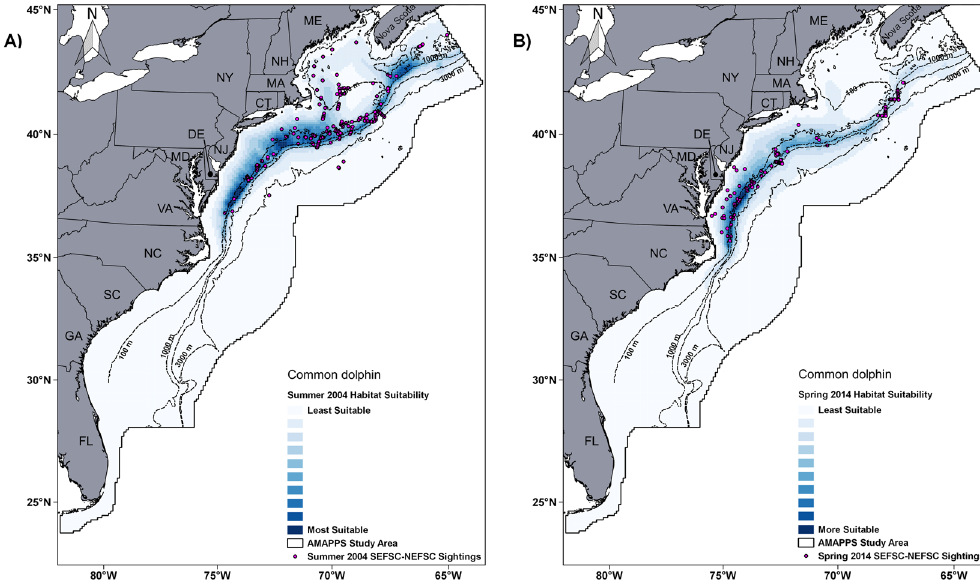
Figure 4. Robustness validation results of the common dolphin habitat model. Habitat suitability for ( A ) summer 2004; and ( B ) spring 2014 overlapped with the actual species sightings for the correspondent season and year. These sightings were not included in the habitat model